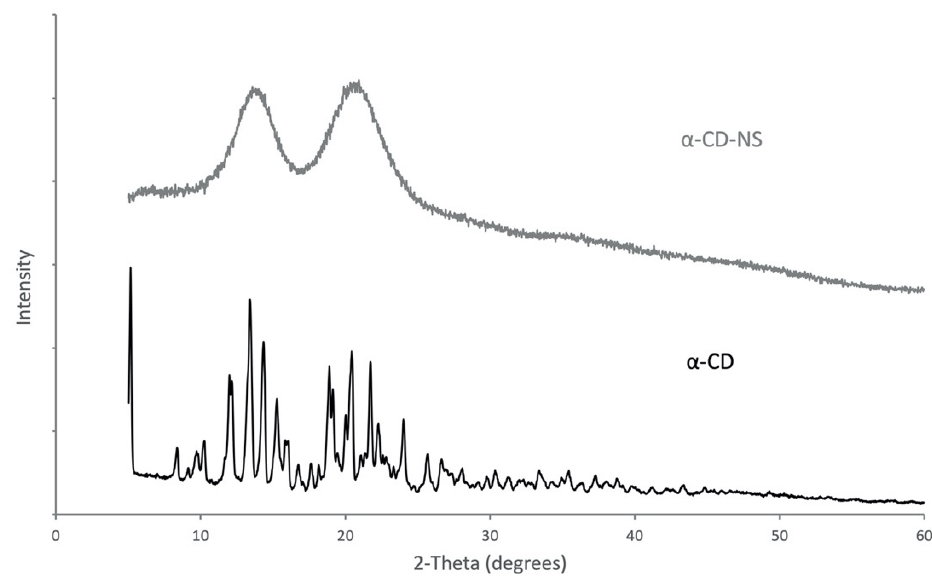
Figure 4. X-ray diffraction spectra for pure α -CD and the synthesized α -CD-NS.